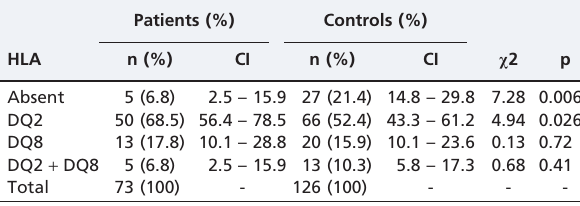
Table 2 - Frequencies of genotypes DQ2 and DQ8 in patients and control relatives.